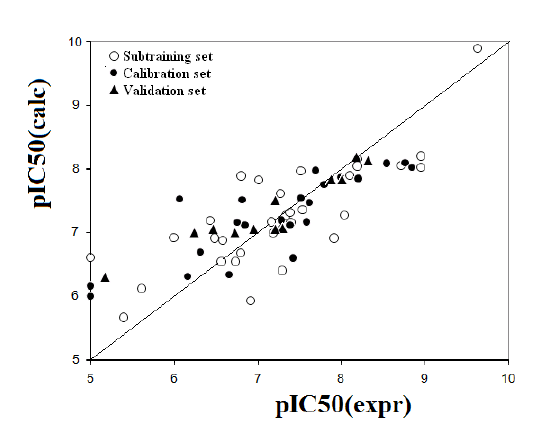
Figure 3. Graphical representation of the model calculated with Eq.